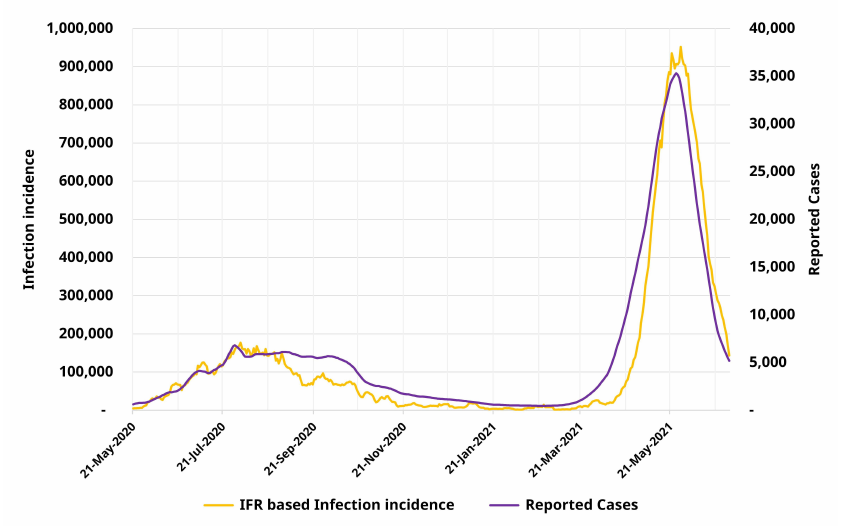
Figure 1. Time-series graph of reported cases and IFR-based infection occurrence estimates for Tamil Nadu from 21-May-2020 to 30-June-2021. Table 2. IFR-based cumulative infection incidences in Wave-II.